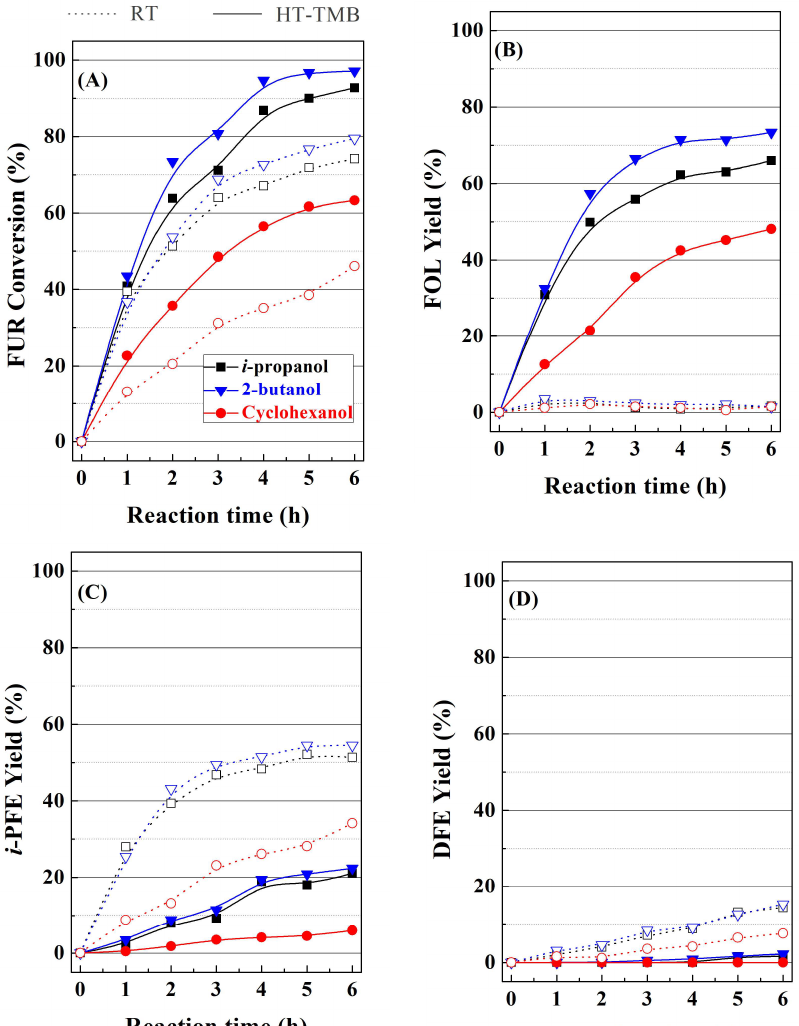
Figure 10. ( A – D ) Influence of the sacrificing alcohol on the catalytic performance with RT and HT-TMB catalysts for the MPV reaction of FUR. (Experimental conditions: 0.1 g of catalyst, reaction temperature: 110 °C, i -POH/FUR molar ratio: 50, FUR/Catalyst mass ratio: 1).